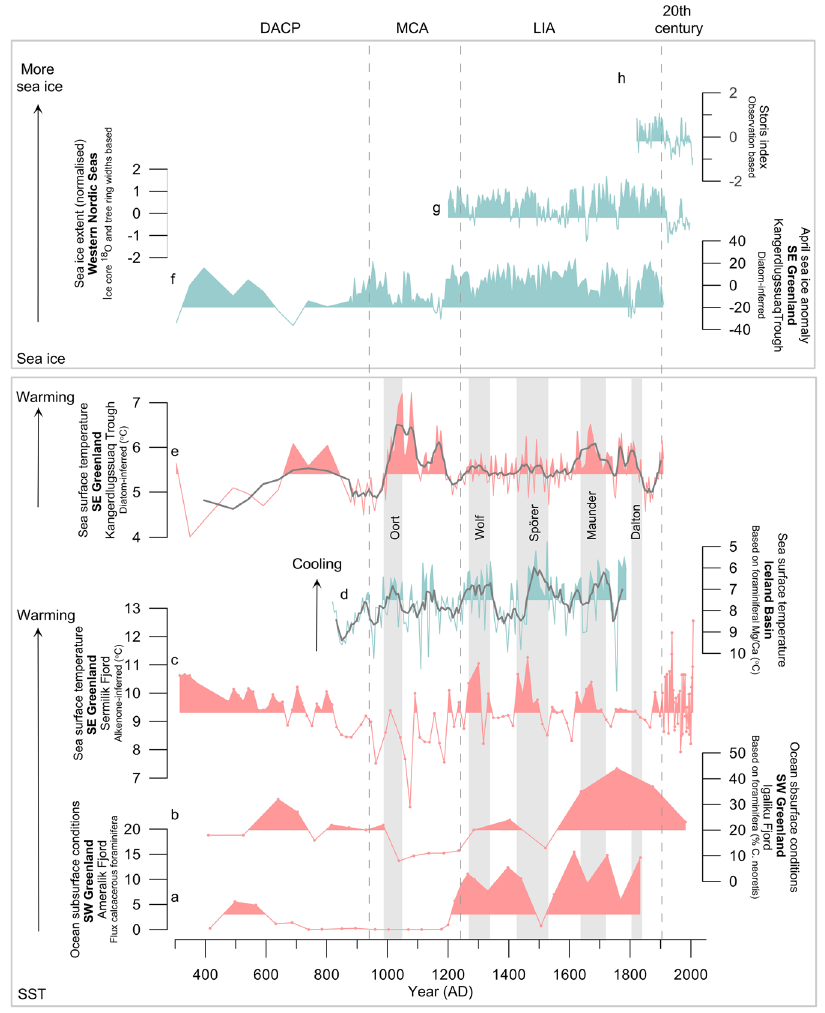
Figure 2. Paleoclimate records off and near Greenland. ( a ) Flux of calcareous foraminera in core 248260–2 (Ameralik Fjord, SW Greenland) as indicator of subsurface ocean warming 39 . ( b ) Relative amount (%) of foraminifera C . neoteretis in core PO 243–451 (Igaliku Fjord, SW Greenland) as indicator of ocean subsurface warming 40 . ( c ) Alkenone-based SST reconstruction from sediment core ER07 (Sermilik Ford, SE Greenland, this study). ( d ) Thermocline temperature reconstruction based in Mg/Ca in G . inflata from core RAPiD-17–5P plotted on a reversed Y axis (Iceland Basin) 28 . ( e ) Diatom-based August SST reconstruction from core MD99– 2322 (Kangerdlugssuaq Trough, SE Greenland) 26 . ( f ) Diatom-based April sea-ice concentration anomalies in the same core as ( e ). ( g ) Greenland Sea winter sea-ice extent reconstruction of the Western Nordic Seas based on tree-ring widths and ice core 18 O records from Fennoscandia and Svalbard, respectively 43 . ( h ) Fram Strait sea-ice export reconstruction from the Storis index; a proxy for sea-ice in the EGC 46 . Grey lines on ( d ) and ( e ) show 5-yr running